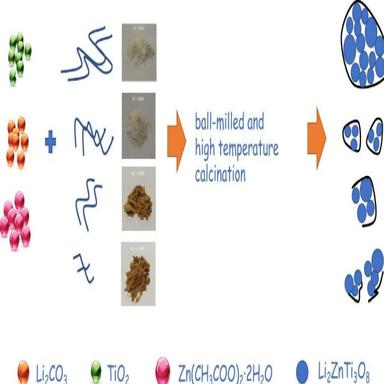
Synthetic procedure of N-doped carbon coated Li2ZnTi3O8 samples.